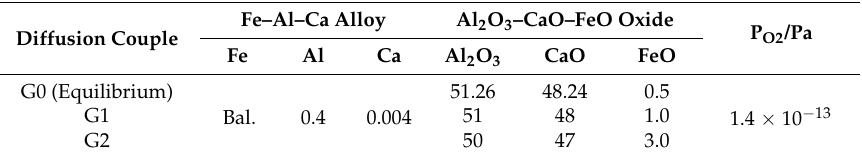
Table 1. Initial compositions of the Fe–Al–Ca alloy and Al 2 O 3 –CaO–FeO oxide used in the heat treatment experiment at 1473